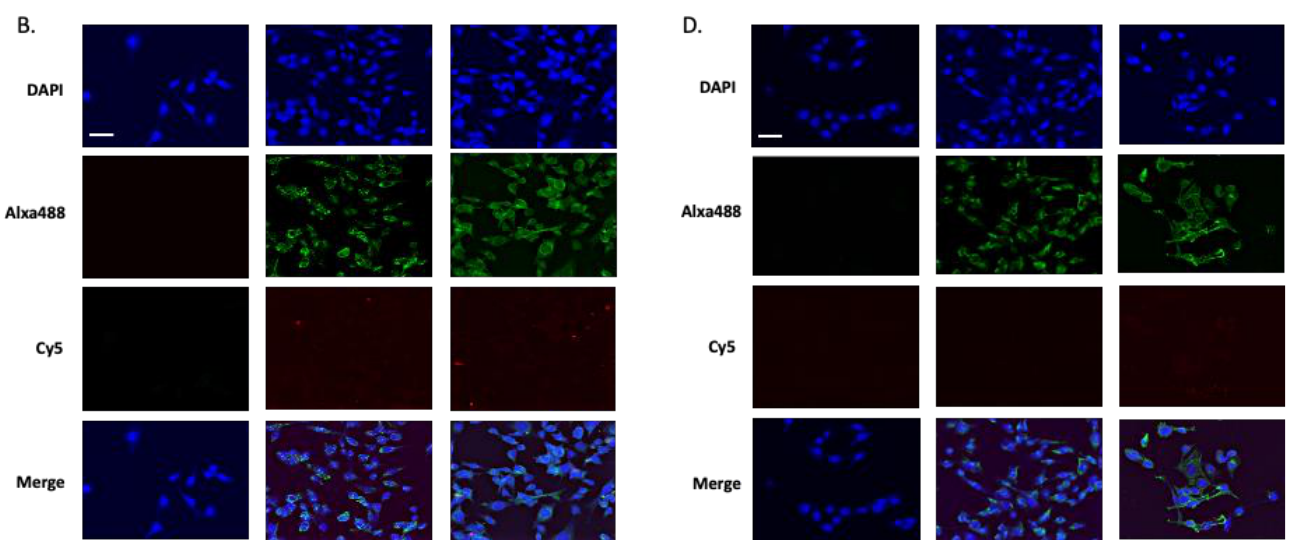
Figure 1. Confocal microscopy images of ( A ) LM7 human metastatic osteosarcoma cells and ( B ) OS482 mouse metastatic osteosarcoma cells after incubation with Cy5 labelled IO-nanocages for 6 h. ( C ) LM7 cells and ( D ) OS482 cells were pretreated with endocytosis inhibitors, nystatin (50 μ g/mL) and Pitstop2 (25 μ M) before incubation with Cy5 labelled IO-nanocages to evaluate the endocytic pathway of IO-nanocages in each cell line. Cell nuclei were stained with DAPI (blue), red represents Cy5 labelled IO-nanocages, and green indicates caveolin-1/Clathrin heavy chain antibody with Alaxa488 secondary antibody. The scale bar = 20 μ m.